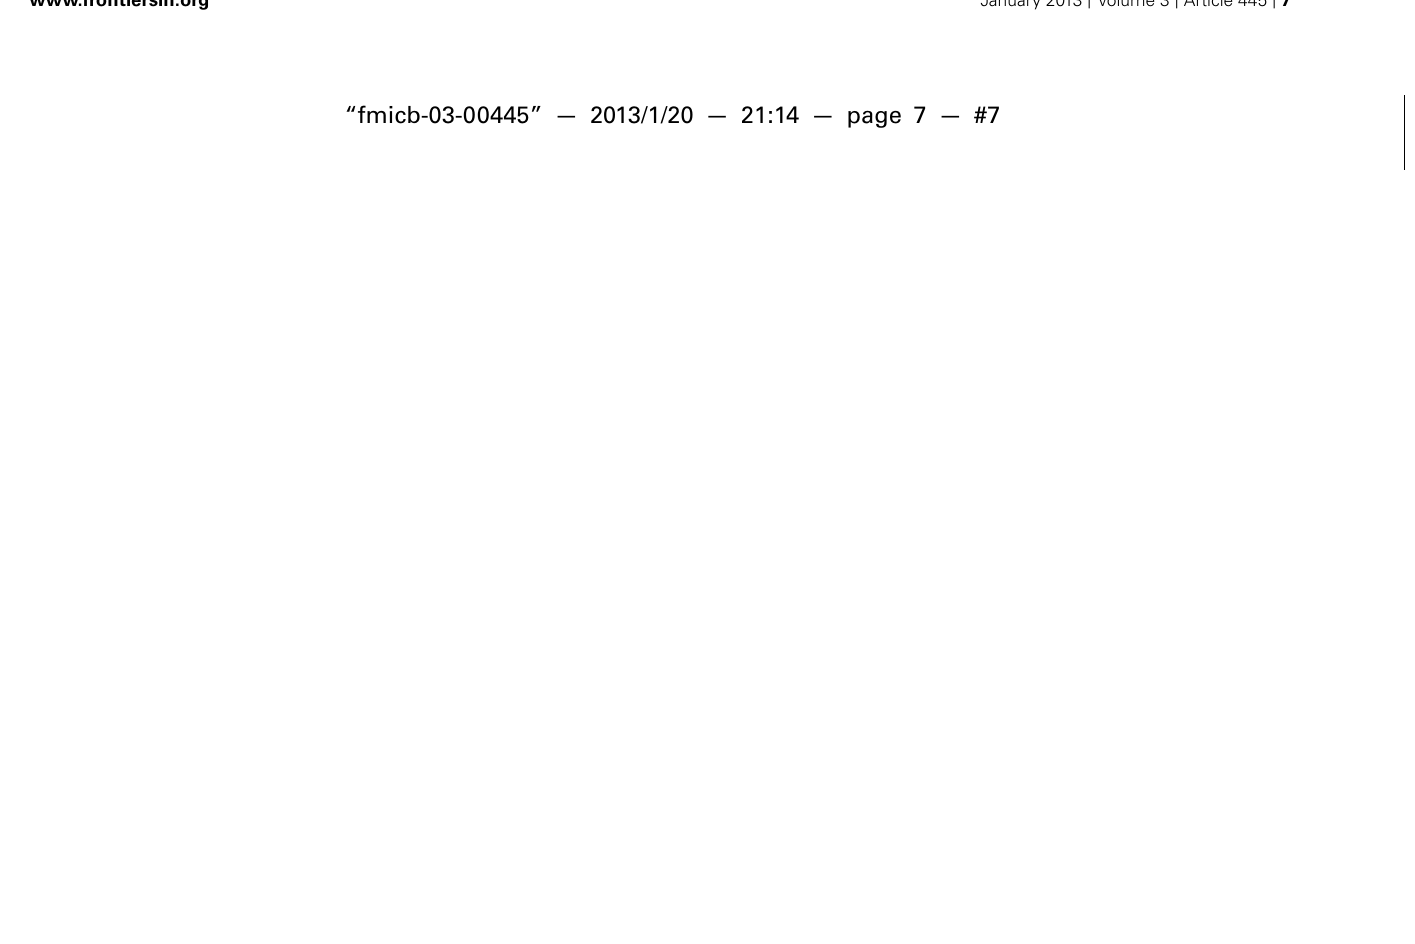
(2012), a subset of the soil/sediment cluster. Coverage of archaeal amo A gene diversity in the clone libraries ranged from 92.9 to